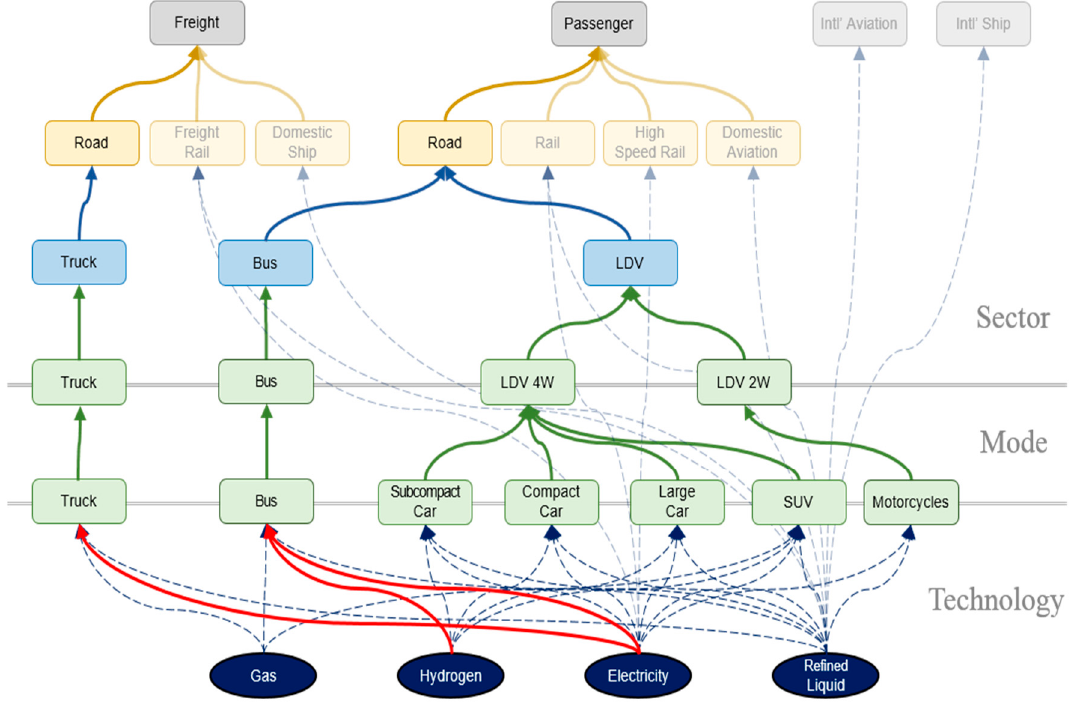
Figure 3. New nesting structure for the transportation sector in GCAM-Korea. Note: Red line indicates a newly added technology and blurry figures denote non-road transportation sectors.